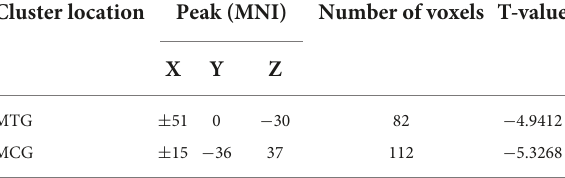
TABLE 2 Regions showing significant differences in VMHC between lTLE patients and HCs. Cluster location Peak (MNI) Number of voxels